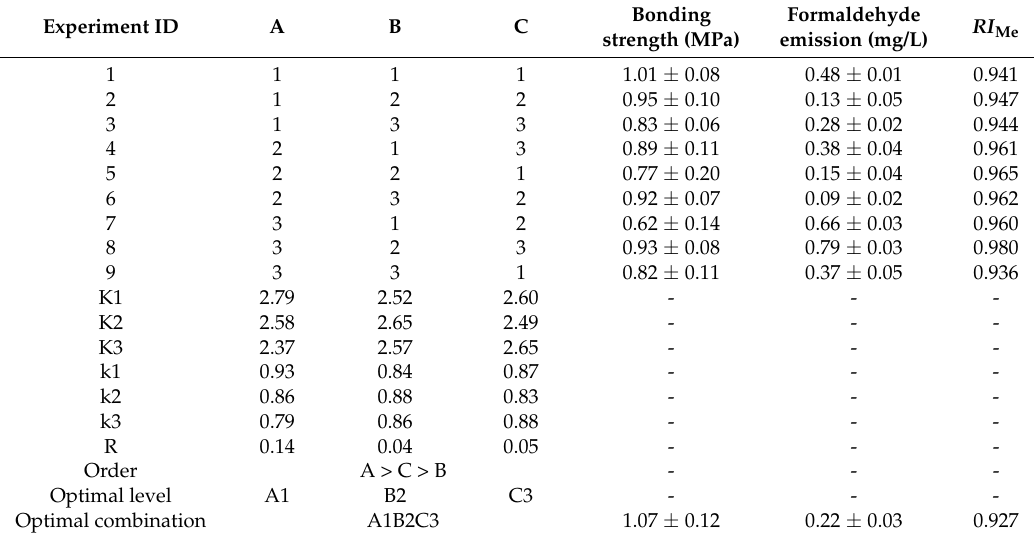
Table 2. Bonding strength and formaldehyde emission of phenolic resins, and relative absorbance values of functional group ( RI Me ) of